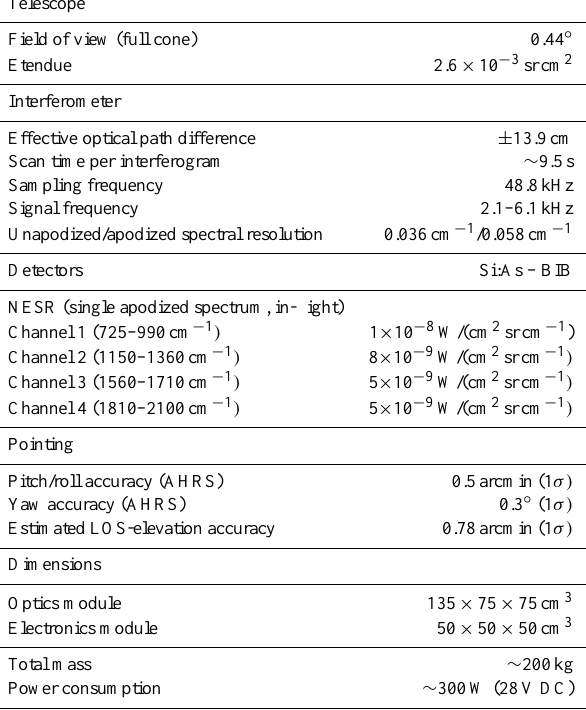
Table 1. Characteristics of MIPAS-STR in the current